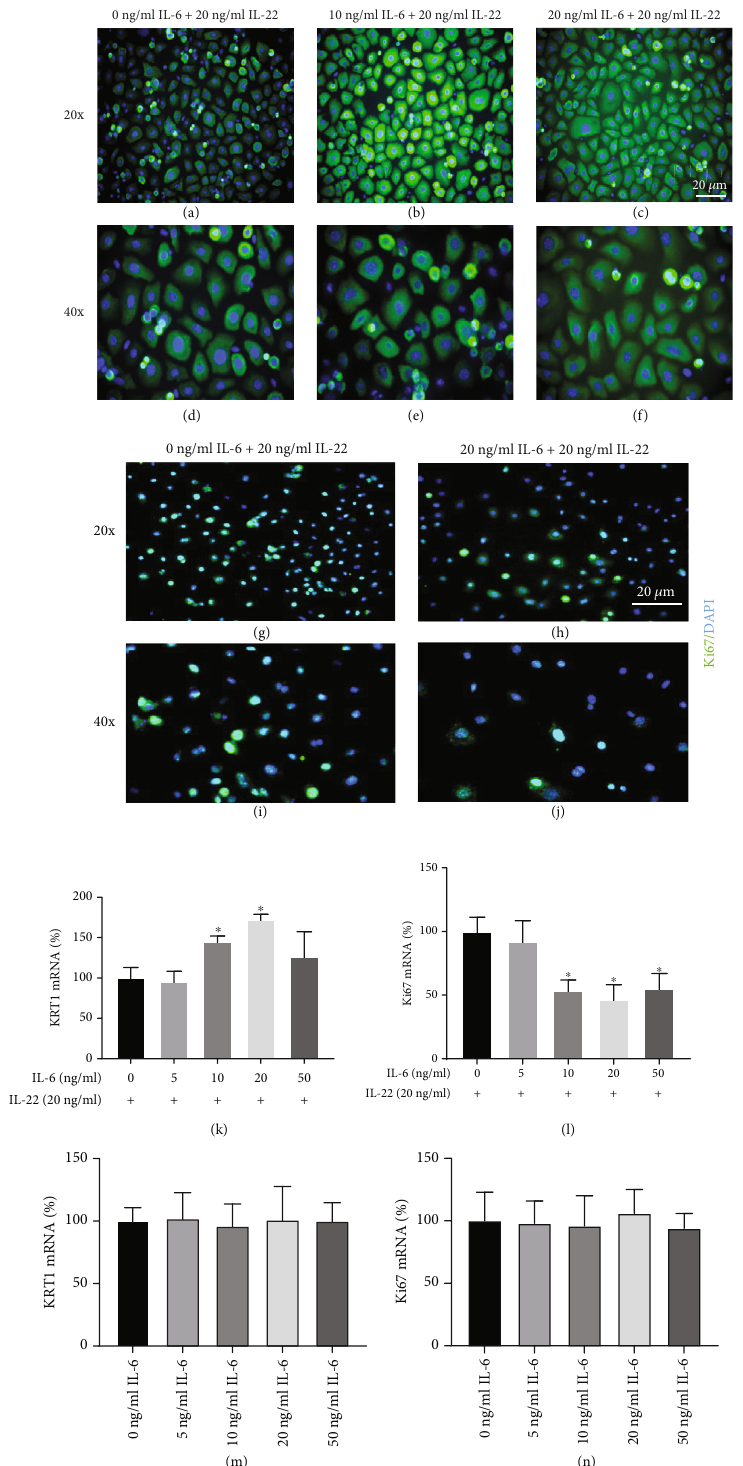
Figure 4: IL-6 reduces the e ff ect of IL-22 on keratinocyte di ff erentiation and proliferation. Primary keratinocytes were pretreated with rmIL-6 for 24 hours followed by exposure to 20ng/ml rmIL-22 for 24 hours (a – f and g – j) or 4 hours (k and l). Immunohistochemical analysis of IL-6KO keratinocyte expression of KRT1 (a – f) or Ki67 (g – j) (green) protein and nuclear staining with DAPI (blue). Representative images are shown. KRT1 expression (k) and Ki67 (l) mRNA expression were analyzed by RT-PCR. Keratinocytes were exposed to rmIL-6 alone in a dose-dependent manner for 4 hours, and KRT1 (m) and Ki67 (n) mRNA were analyzed by RT-PCR. Data are mean ± SD . ∗ Signi fi cantly di ff erent from 0 ng/ml rmIL-6 ( p ≤ 0 : 05 , n = 4 separate